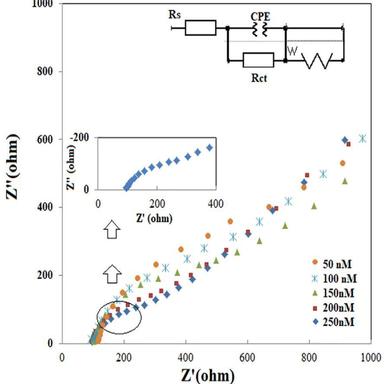
Nyquist plots of the GO-imi- (CH2)2-NH2 /CPE with different concentrations of Pb(II) in acetate buffer (pH 5.0).